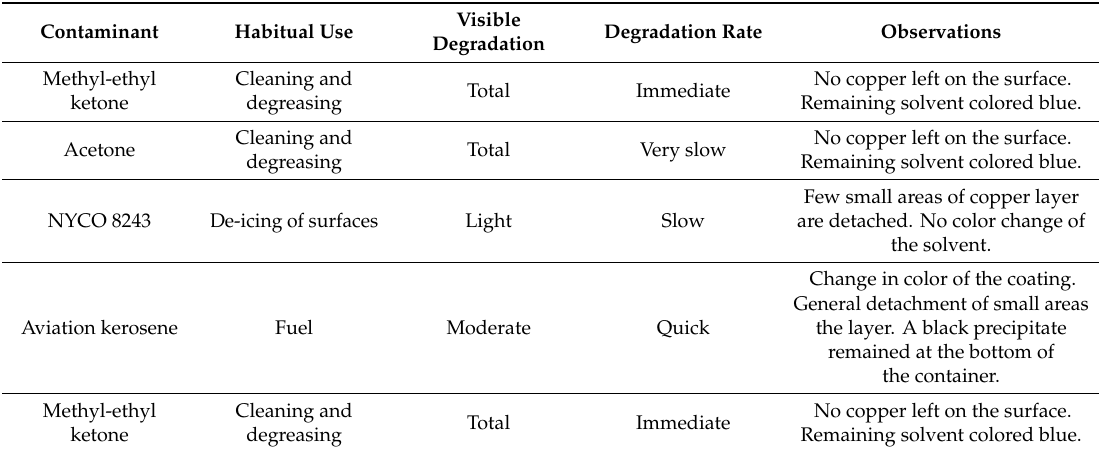
Table 3. Degradation behavior of copper electroless coatings that were exposed to several products. Visible Contaminant Habitual Use Degradation Rate Observations Degradation Methyl-ethyl Cleaning and No copper left on the surface. Total Immediate ketone degreasing Remaining solvent colored blue. Cleaning and No copper left on the surface. Acetone Total Very slow degreasing Remaining solvent colored blue. Few small areas of copper layer NYCO 8243 De-icing of surfaces Light Slow are detached. No color change of the solvent. Change in color of the coating. General detachment of small areas Fuel Moderate Quick the layer. A black precipitate remained at the bottom of the container. Methyl-ethyl Cleaning and No copper left on the surface. Total Immediate Remaining solvent colored ketone degreasing